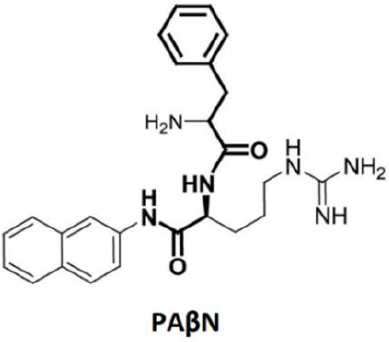
Figure 6. Chemical structure of PA β N. Table 1. Examples of EPIs from non-plant sources against Gram-negative bacteria.